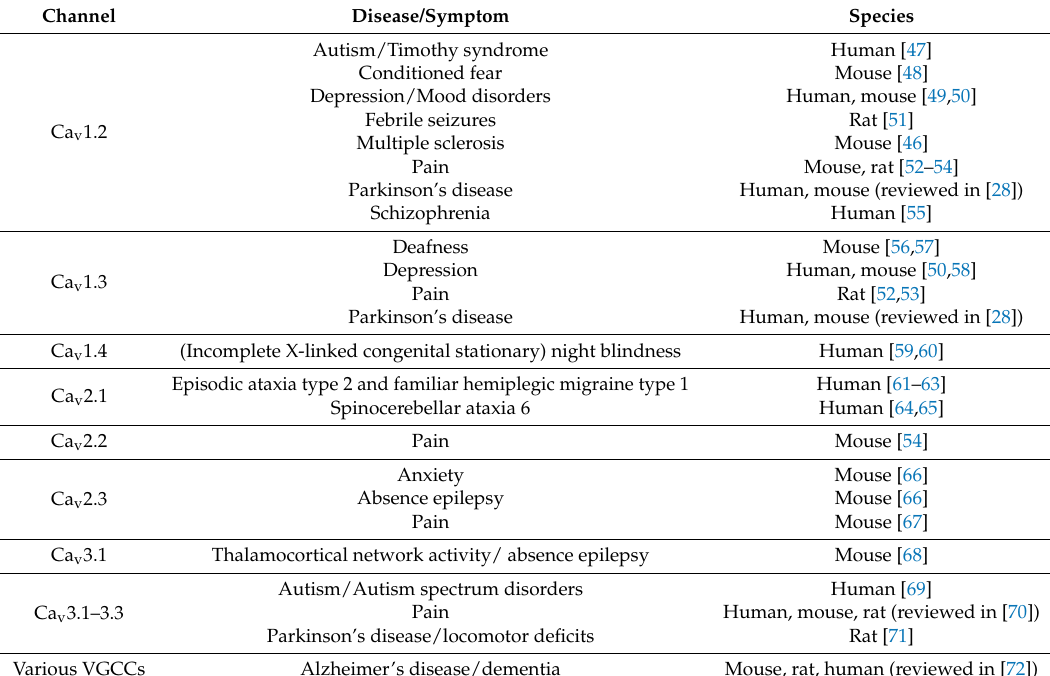
Table 2. Involvement of VGCCs in neurologic and psychiatric